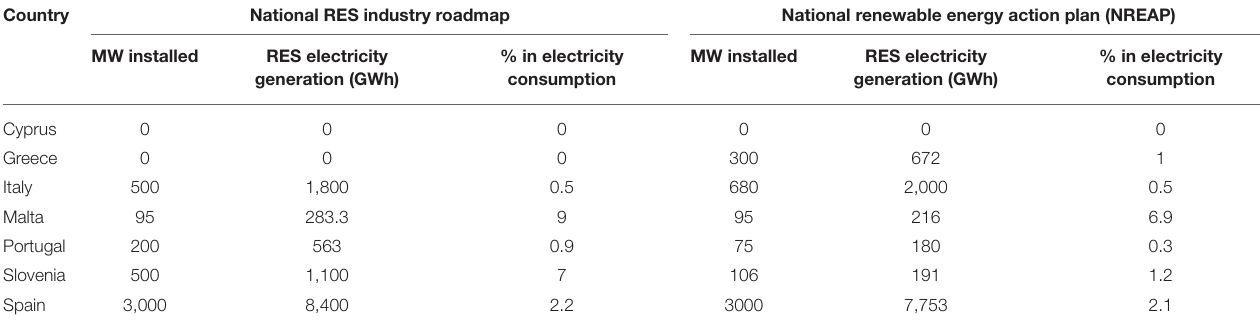
TABLE 1 | Projections for renewable electricity in 2020 from offshore wind energy (Zervos et al., 2011). Country